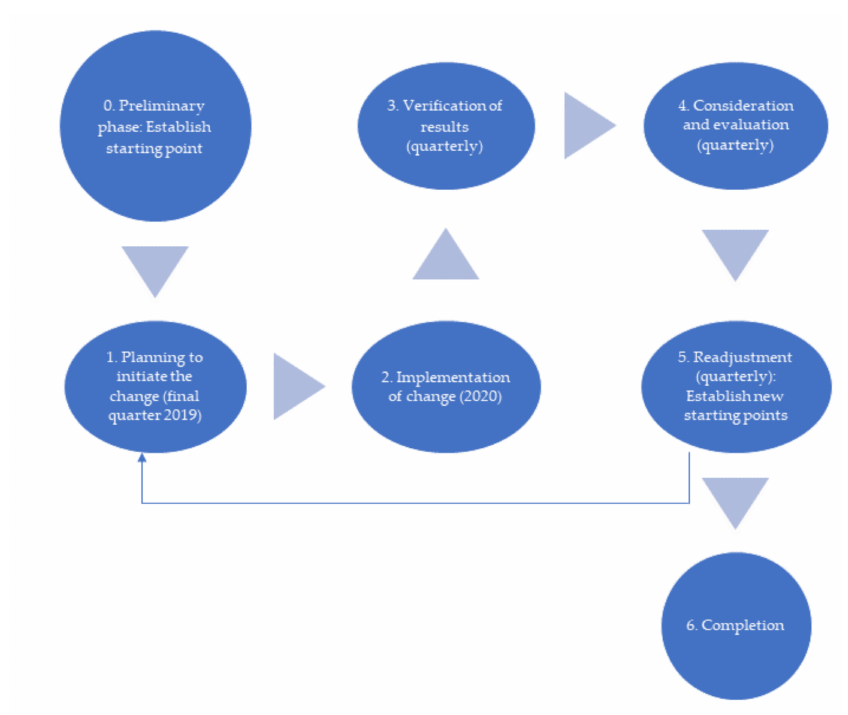
Figure 2. Action research methodology